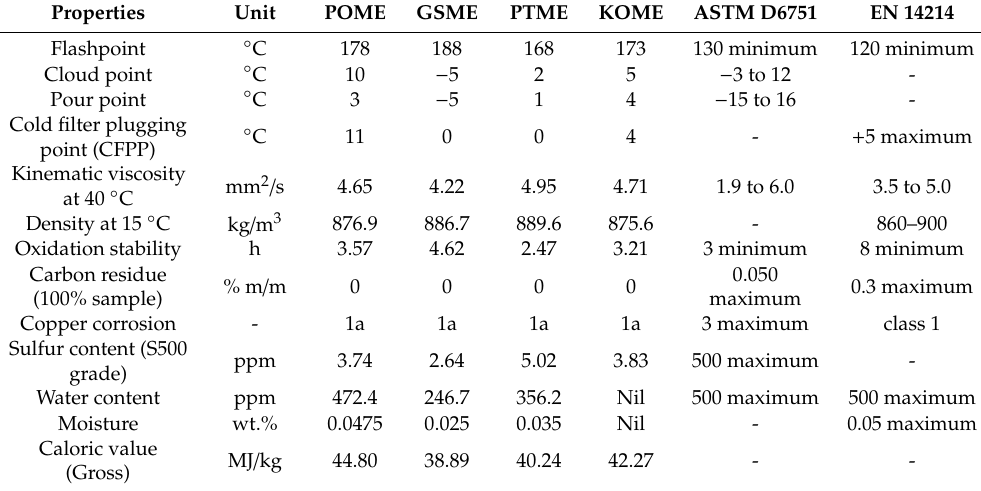
Table 4. Characteristics of